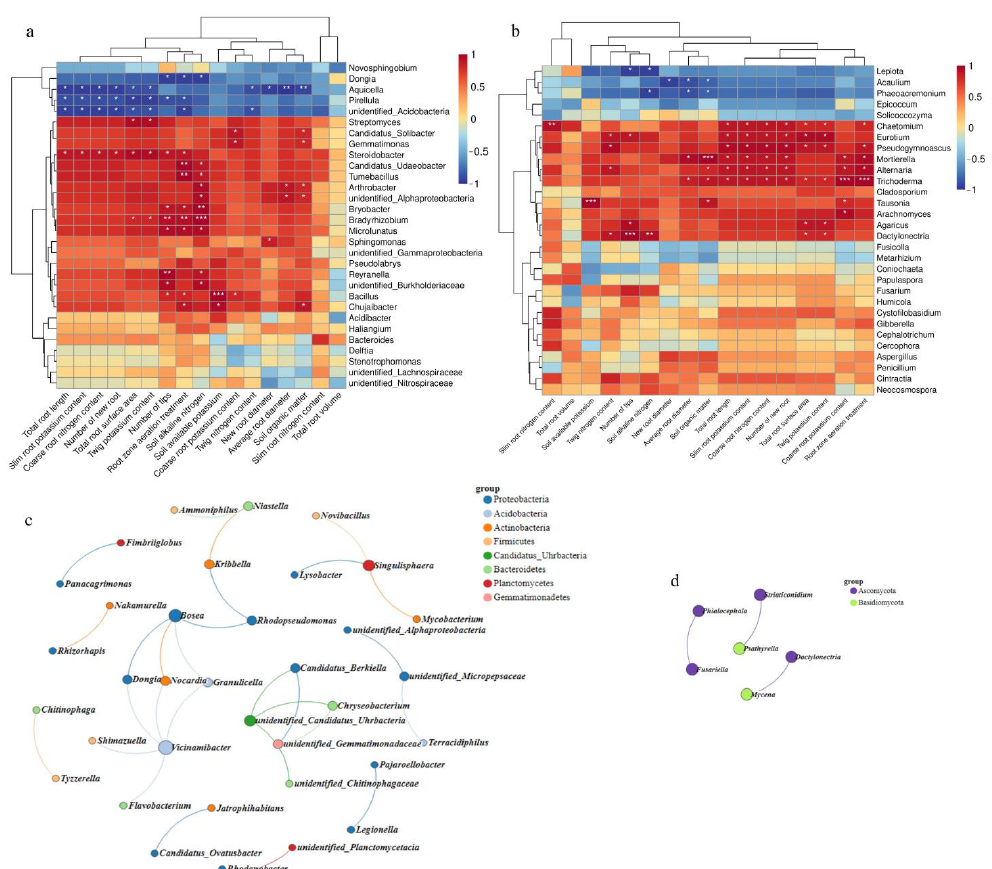
Figure 7. Analysis of root and twig growth’s correlation with the microbial community: ( a ) Analysis of root and twig growth’s correlation with bacteria. ( b ) Analysis of root and twig growth’s